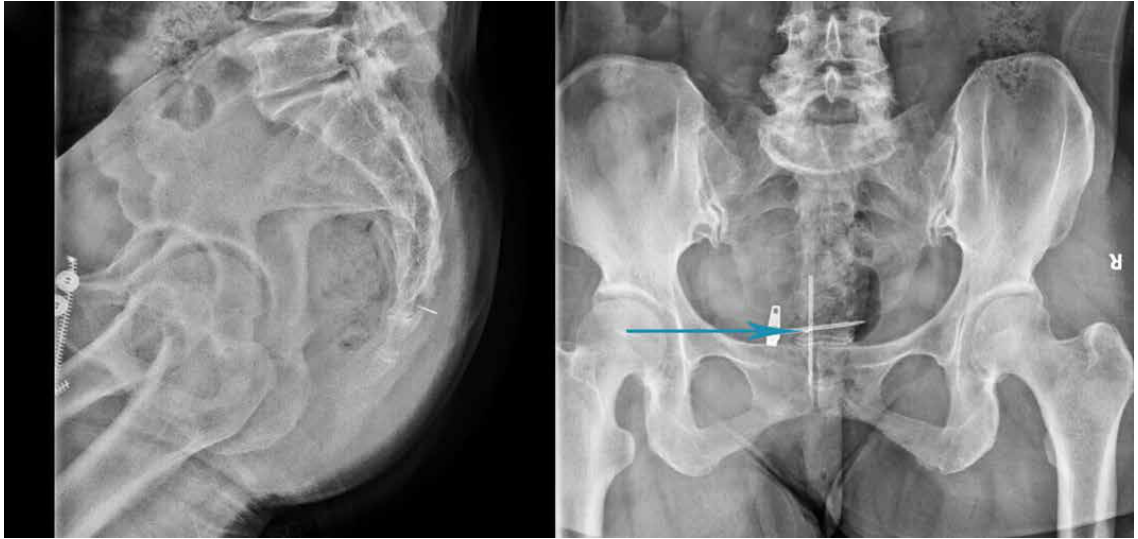
Figure 1: The location of the broken needle in lateral and anteroposterior radiographs, which located in the intersection (cyan arrow) of cross two needles of 20 ml